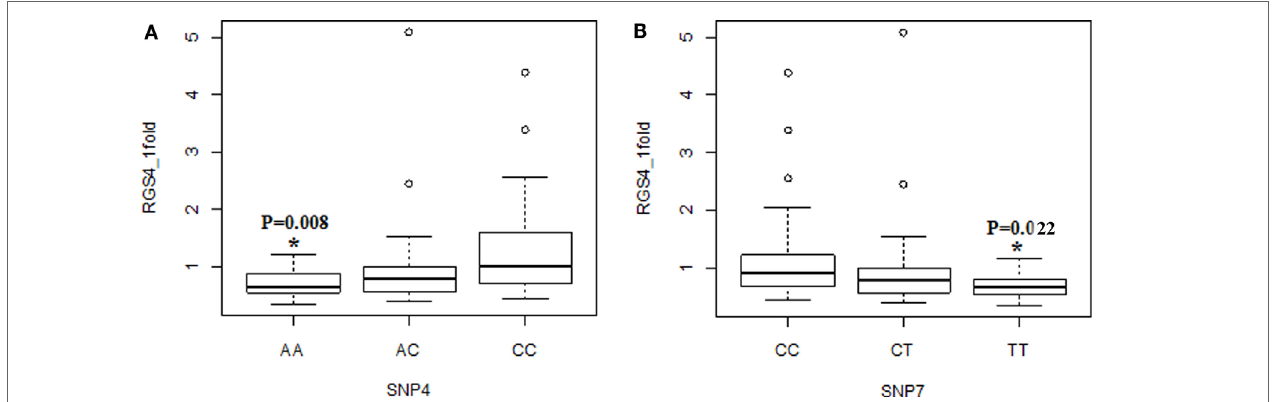
FigUre 4 | association of RGS4-1 mrna expression levels with the genotypes of snP4 and snP7 . The genotype AA of SNP4 was associated with the lower expression level of RGS4-1 , and CC was related with the higher expression of RGS4-1 [ F (3,77) = 4.93, overall p = 0.0035, SNP4 genotype p = 0.0104] (a) . The genotype TT of SNP7 was associated with the lower expression level, and CC with higher expression level of RGS4-1 [ F (3,77) = 4.20, overall p = 0.0083, SNP7 genotype p = 0.0263] (B)